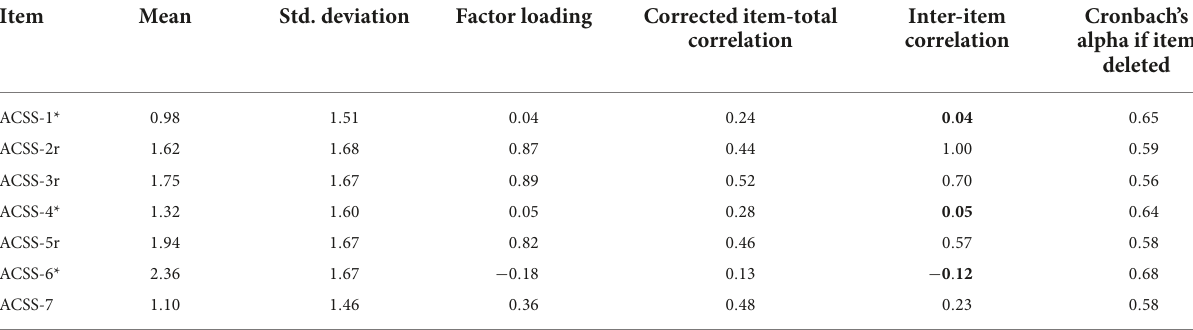
TABLE 3 Construct and factor loading of ACSS-FAD-B ( n = 1,207).